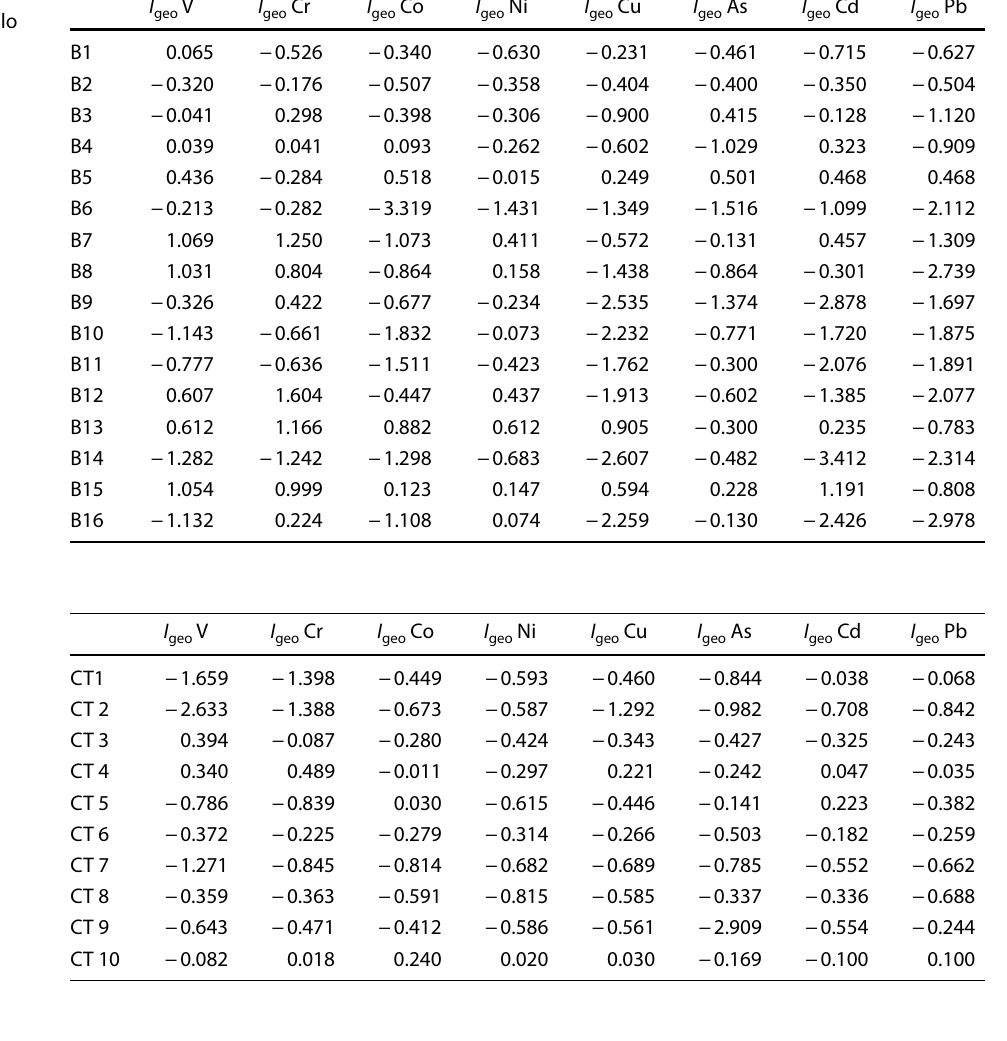
Table 3 Geoaccumulation index ( I ) for Borgo Montello geo